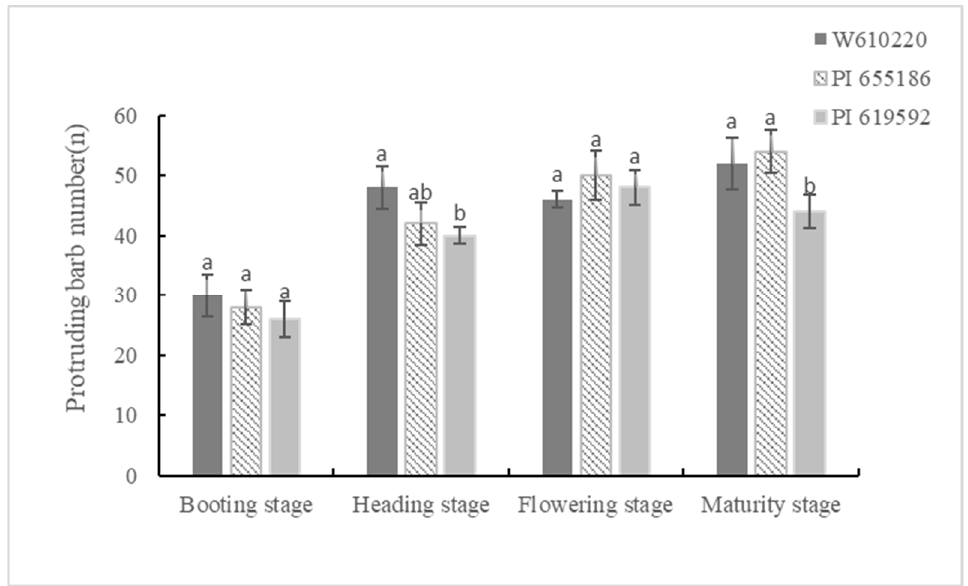
Figure 2. The number of protruding barbs in awns at four stages of three accessions. W610220, long awn, PI 655186, medium awn, PI 619592, short awn. Error bars represent mean ± standard deviation. Different normal letters mean significant differences among different treatments at 0.05 level.